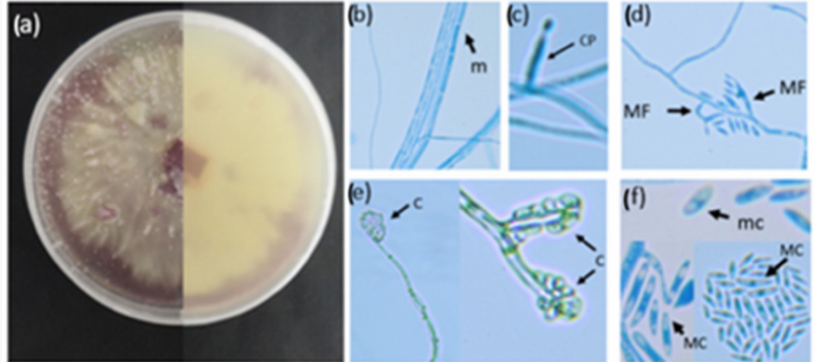
Figure 1. Micromorphological characteristics of FOL (Isolate UPFC): ( a ) Colony morphology on PDA front (left) and back of the plate (right), ( b ) aseptate mycelia—m, ( c ) initial formation of conidiophore—CP, ( d ) Monophialides—MF, ( e ) formation of head of conidia—C, and ( f ) oval shaped microconidia—mc and sickle-shaped macroconidia—MC.